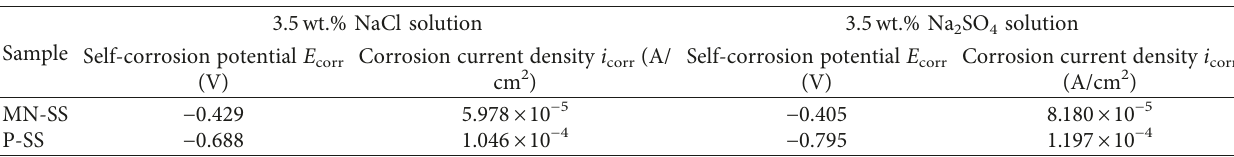
Table 1: The electrochemical parameters of potentiodynamic polarization curves.